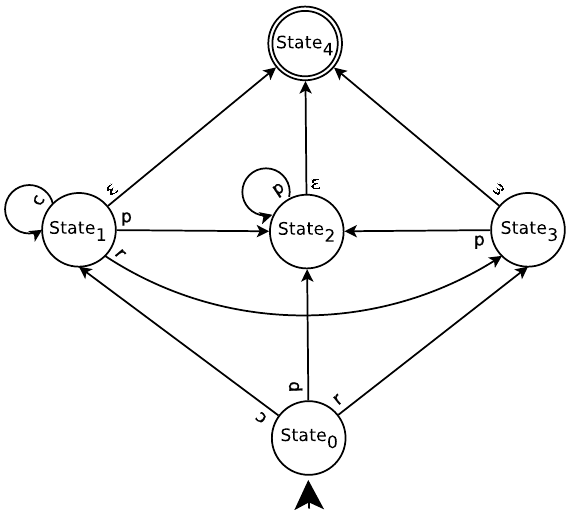
Figure 4: NFA- ε recognizing valley-free AS paths